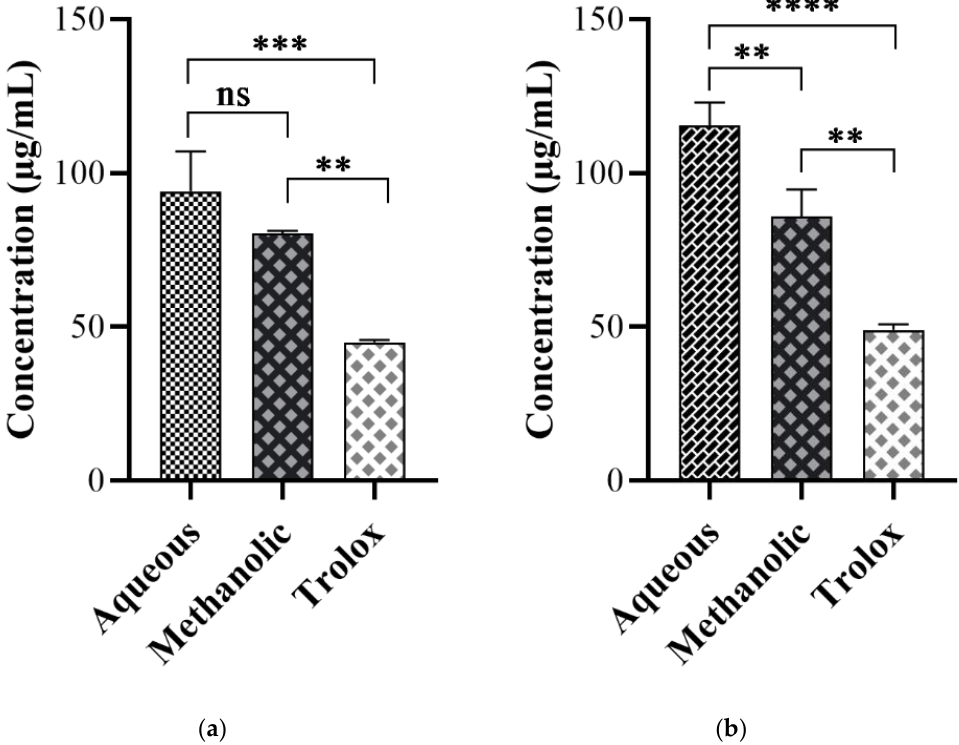
Figure 2. The EC 50 of A. angustiloba leaves extracts for ( a ) DPPH and ( b ) ABTS radical scavenging activities. Data show mean ± SD, n = 3. Values of ∗∗ p < 0.01, ∗∗∗ p < 0.001, ∗∗∗∗ p < 0.0001 were considered statistically different & ns is denoted as not statistically significant.